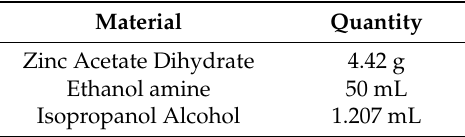
Table 4. Ingredients for ZnO/GO